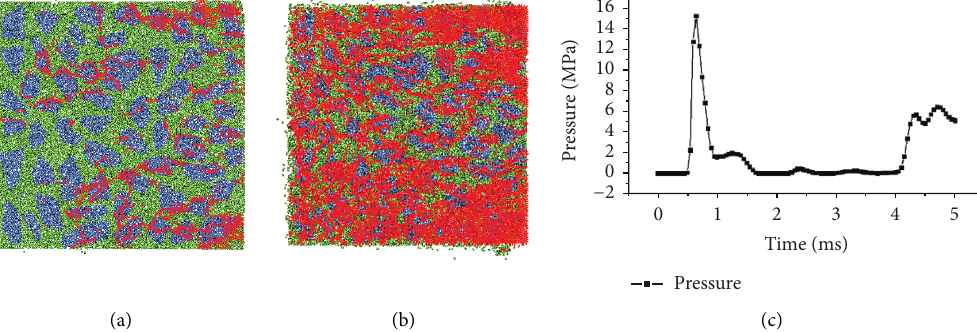
Figure 19: (a) The damage of point D0 at normal temperature, (b) the damage of point D0 at 500K, and (c) the compressive wave.